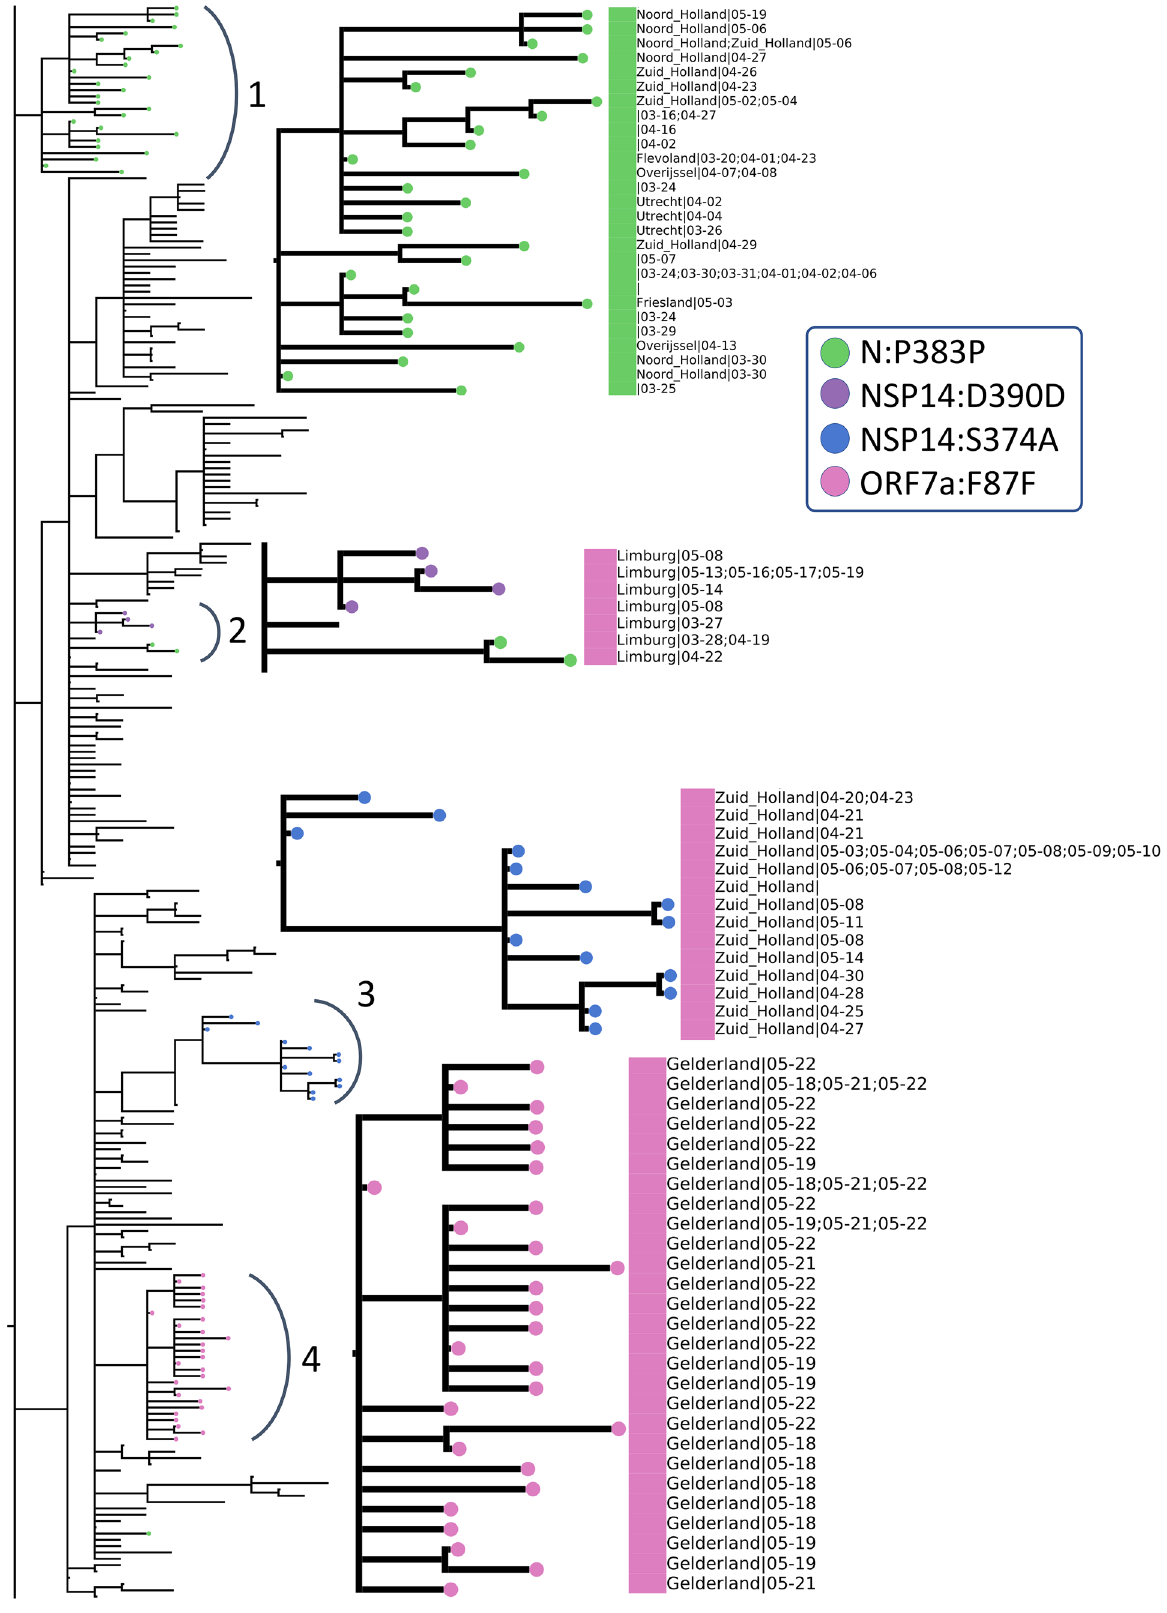
Figure 9. Zoomed-in view of rectangular representation of the Dutch phylogenetic tree: three regions of focus are numbered next to the corresponding arch. Newer, unique mutations that define deep branching in the tree are drawn in circles and the common mutations within Europe are rectangle (see legend for mutation annotations). Assigned clades are indicated with large rectangle aligned next to the leaves (pink: GH and green: G) and additional information about sequences (location and sequence collection date) are displayed next to the clade color, if